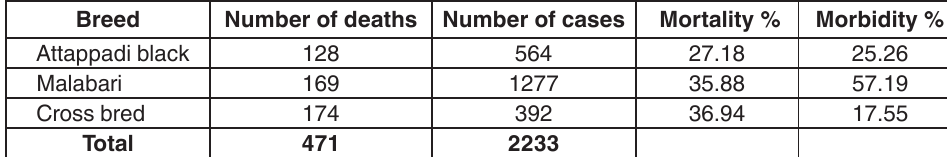
Table 5: Percent mortality and morbidity in different age groups age